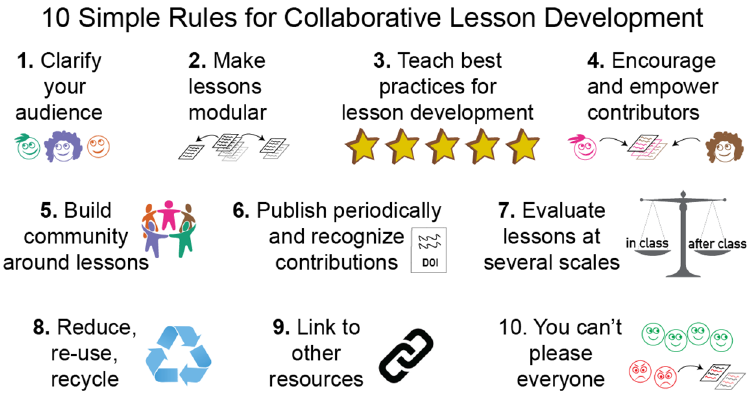
Fig 1. Graphical abstract of 10 simple rules for collaborative lesson development. 1. To clarify your audience, consider writing learner profiles (Box 1). 2. Make lessons modular by breaking them into small, single-purpose modules. 3. Teach your instructors the best practices for developing, delivering, and maintaining lessons. 4. Encourage and empower contributors by making the contribution process transparent and straightforward. 5 Build a community around lessons by creating opportunities for participation and mentorship. 6. Publish new versions periodically and recognize contributors by their unique identifiers (e.g., ORCID). 7. Evaluate lessons during and after class for a complete picture of their efficacy. 8. Reduce, reuse, or recycle lessons before creating a new one from scratch. 9. Link to other resources that complement the lesson content. 10. Remember that you can’t please everyone in your audience or community.